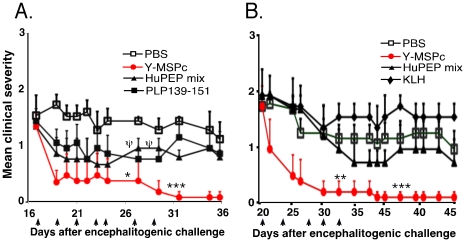
Efficacy of Y-MSPc vs. huPEP mix in reversal of ongoing “complex EAE” associated with multiple potentially pathogenic autoreactivities.(A), Treatment of “complex EAE” induced by mixture of encephalitogenic peptides. BSF1 mice were immunized with huPEP mix emulsified in CFA [a mix of five encephalitogenic peptides, phMOG34-56, phMBP89-104, phPLP139-151, phMOBP15-36 and phOSP55-80, (75 µg each)]. From day 17 after immunization, the mice (n = 5/group) were treated on days indicated by the arrows by i.v. injection with Y-MSPc (75 µg), PLP139-151 (100 µg), or huPEP mix (30 µg of each of the five peptides) in 0.5 ml PBS, or with PBS alone. Ψ, denotes mortality in the huPEP mix-treated group. Two mice died of anaphylactic shock on day 27 and day 29 after the sixth and seventh injection, respectively; data shown after day 29 are for the remaining 3 mice. (B), Treatment of “complex EAE” induced by MSCH. BSF1 mice were immunized with MSCH as described in Methods. From day 20 after immunization, mice with ongoing EAE (n = 5/group) were treated on days indicated by the arrows by i.v. injection with Y-MSPc (75 µg) in 0.5 ml PBS, huPEP mix (7 peptides as in Fig. 4; total 140 µg), KLH (75 µg) or with PBS alone. Results are shown as mean clinical scores +/−SE; *, p<0.05; **, p<0.005; ***, p<0.0005 compared to PBS control group; two tailed unpaired Student's t-test.